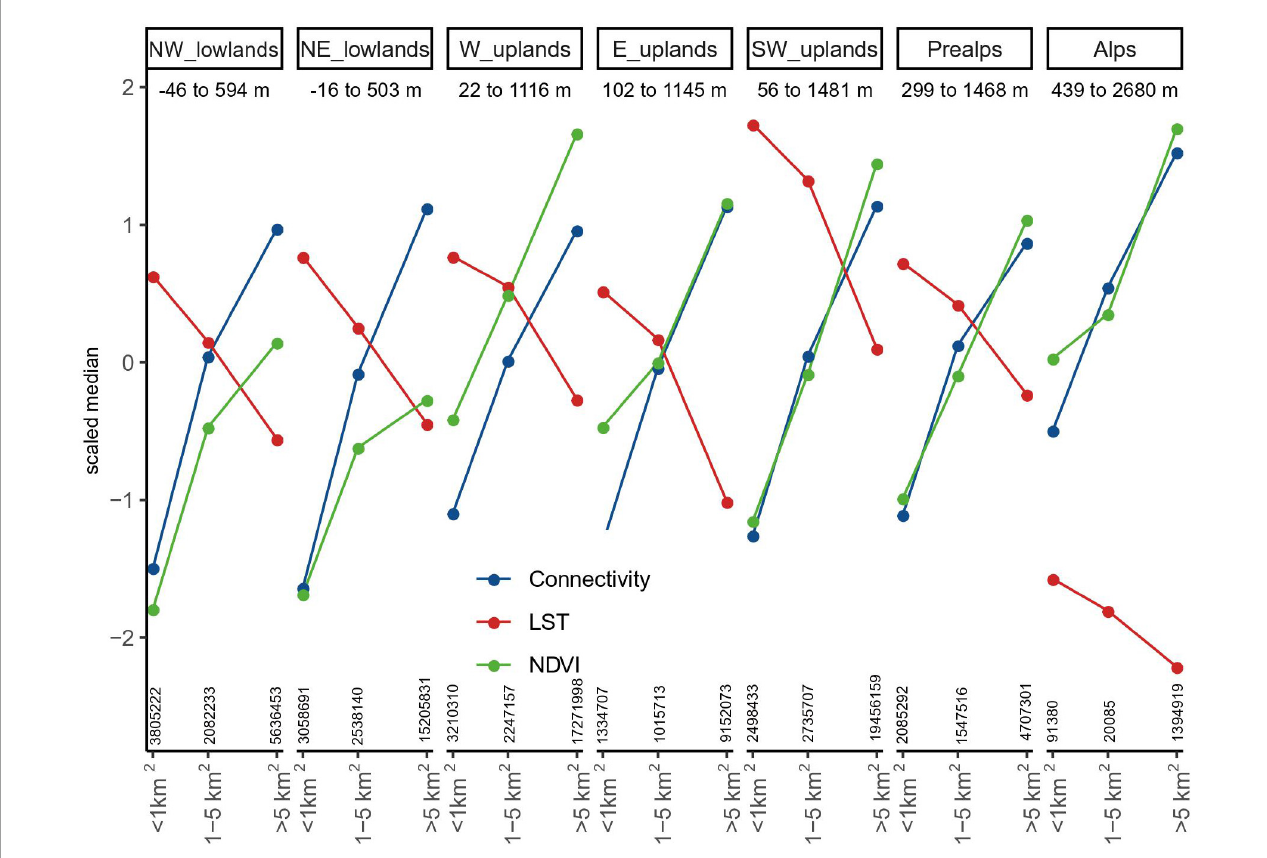
FIGURE3 Scaled median (median per indicator for tree-covered areas in Germany 2022 divided by the standard deviation) per ecoregion with respect to different forest fragment sizes ( < 1 km 2 , 1–5 km 2 , and > 5 km 2 ). The indicators are Thiessen connectivity for forest-covered areas in Germany in 2022 (blue), land surface temperature [land surface temperature (LST); MODIS Aqua MYD11A1] based on the mean of the hottest days in 2022 (red), and the NDVI (MODIS Aqua MYD13A2) based on the maximum value of the growing season 2022 (green). Altitudinal ranges per ecoregion are depicted below the headings. The coverage of each fragment size group is depicted above the X -axis in km 2